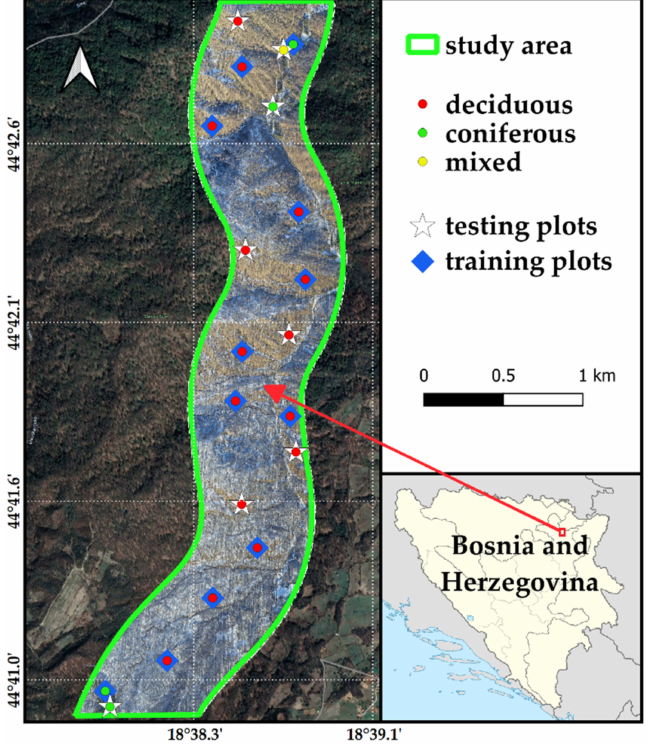
Figure 1. The study area with selected forest plots with the orthophoto in